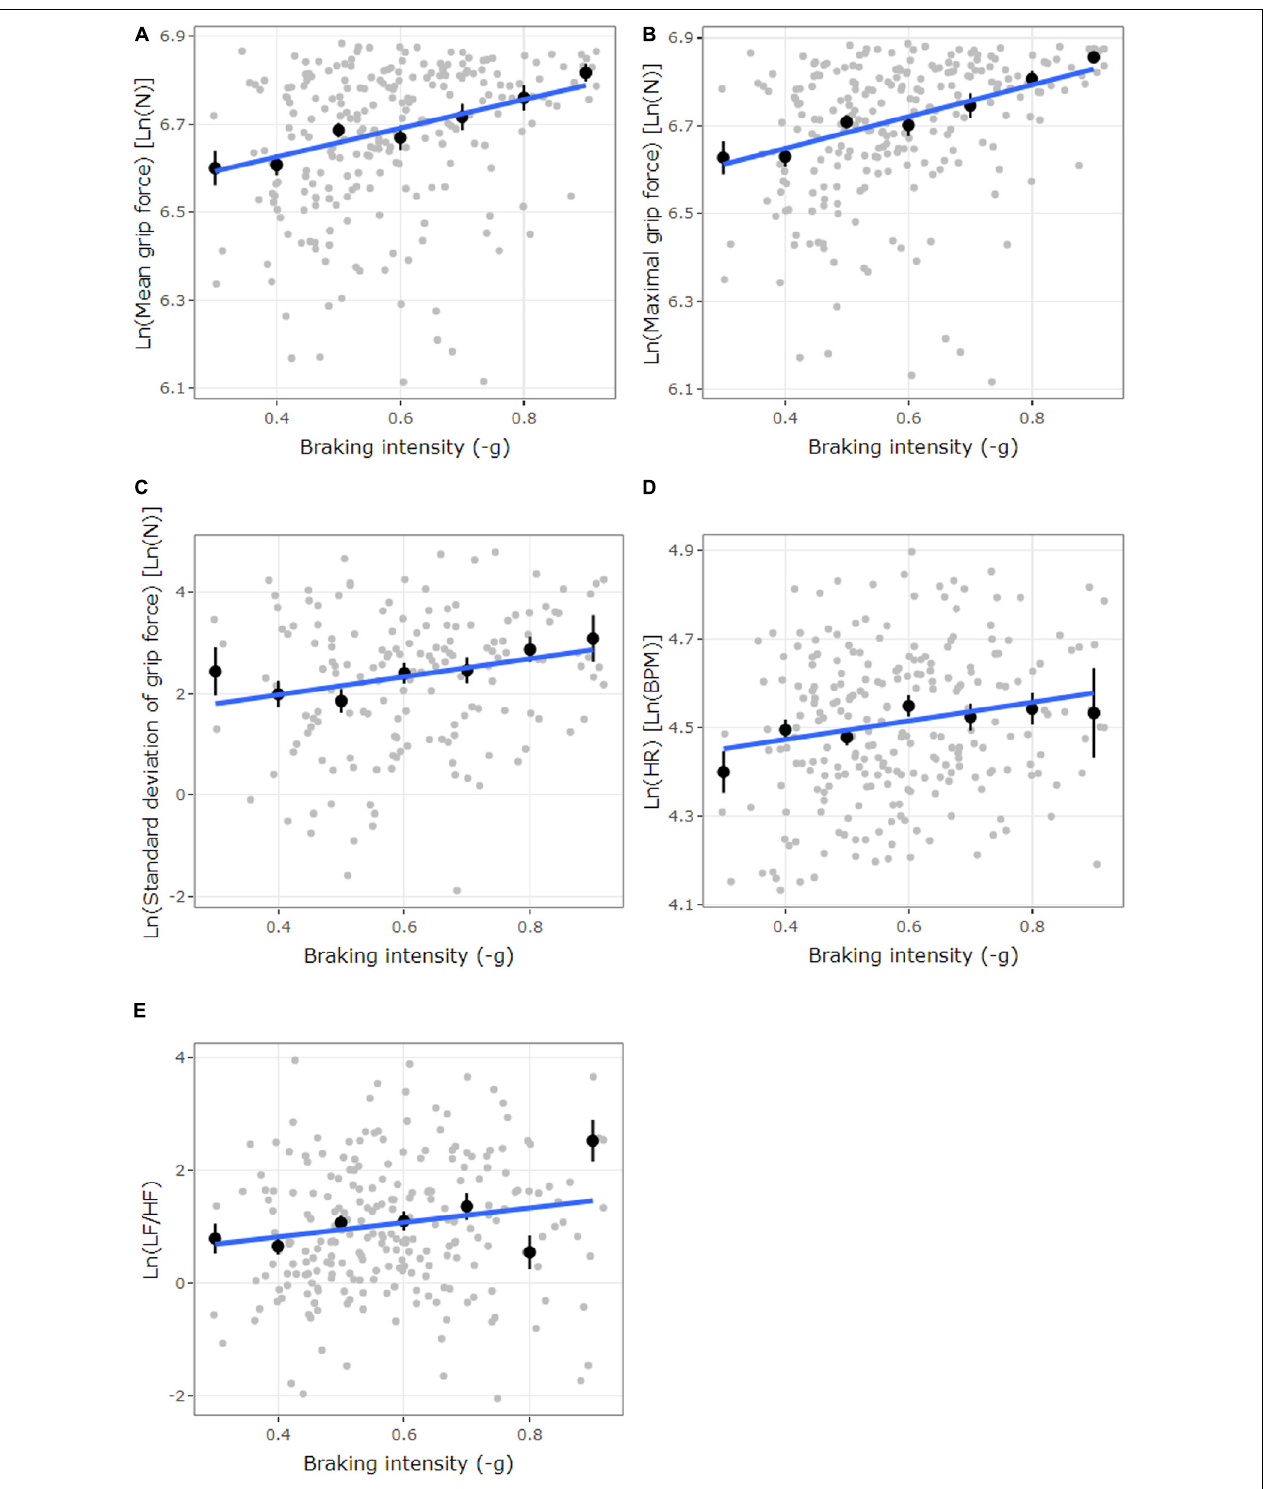
FIGURE 6 | The plots illustrate the significant LMM models described in Table 1 . Higher x -axis values (-g) represent a higher braking intensity in this figure. (A–C) Ln-transformed grip force [Ln(N)], (A) mean grip force, (B) maximal grip force, and (C) standard deviation of grip force, as a function of braking intensity (–g). (D) Ln-transformed HR [Ln(BPM)] as a function of braking intensity (–g). (E) Ln-transformed HRV LF/HF as a function of braking intensity (–g). Gray dots represent observations. Black dots represent the mean of each binned group of observations (according to deceleration), with 95% confidence interval. The blue line represents smoothed conditional means using lm